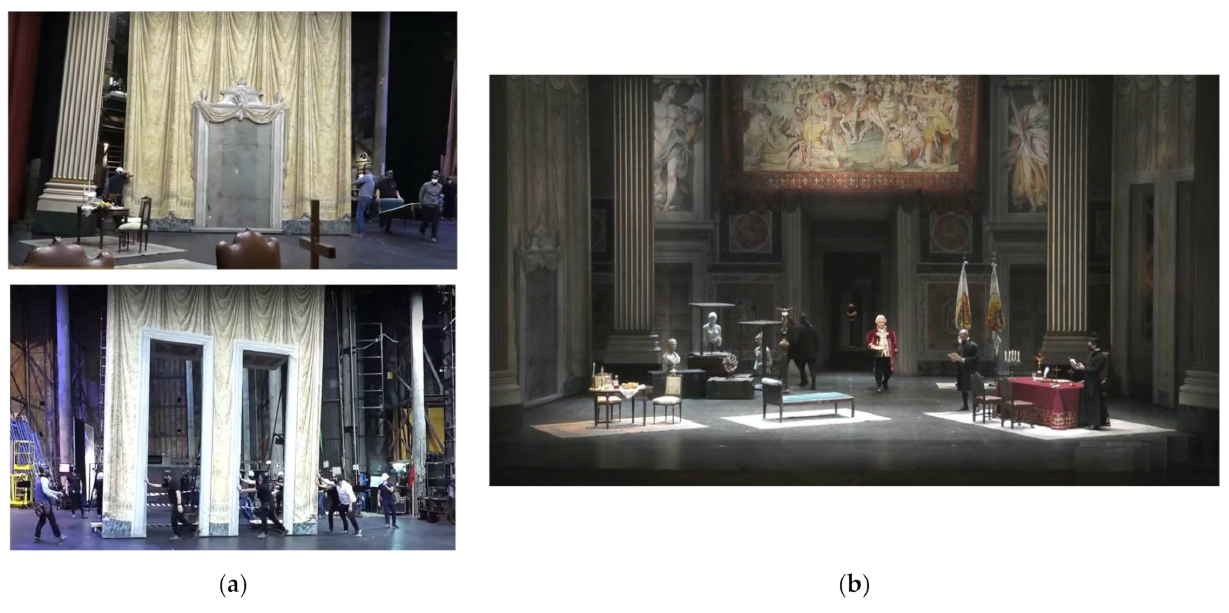
Figure 9. Act II of Tosca at the Teatro Massimo of Palermo (2022): installation ( a ) and final scenery during the performance ( b